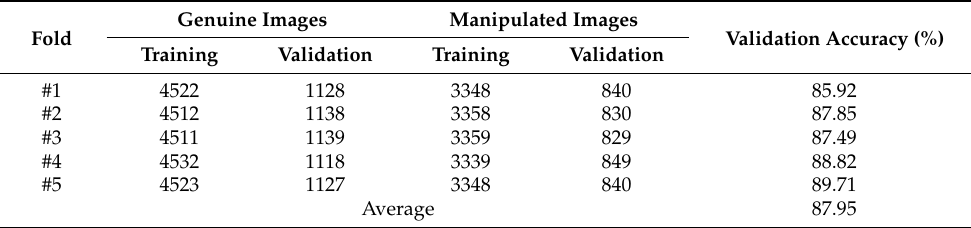
Table 2. Numbers of genuine and manipulated face images for training and validation tasks for each fold and their corresponding validation accuracy using a 5-fold cross-validation.